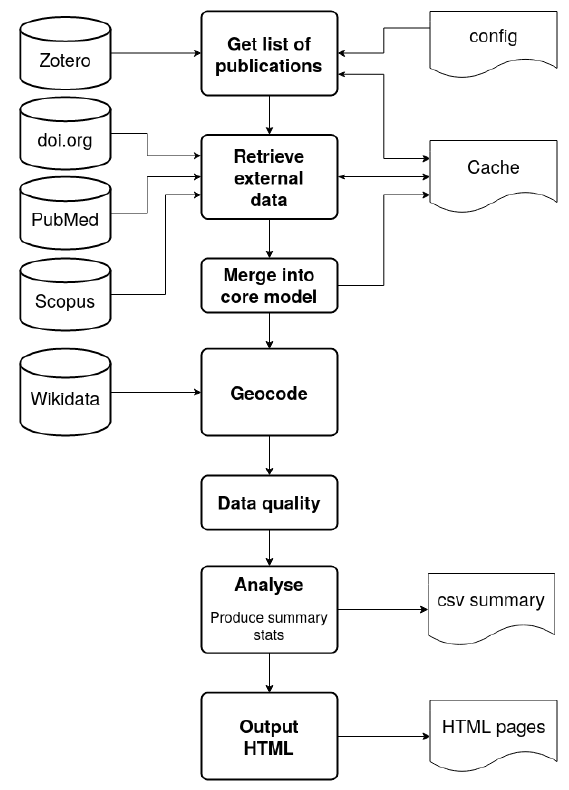
Figure 1. Overview of the PUMA pipeline. The left column shows the sources of data accessed via their APIs, the central column the stages the pipeline with the right column showing input and output of the pipeline.